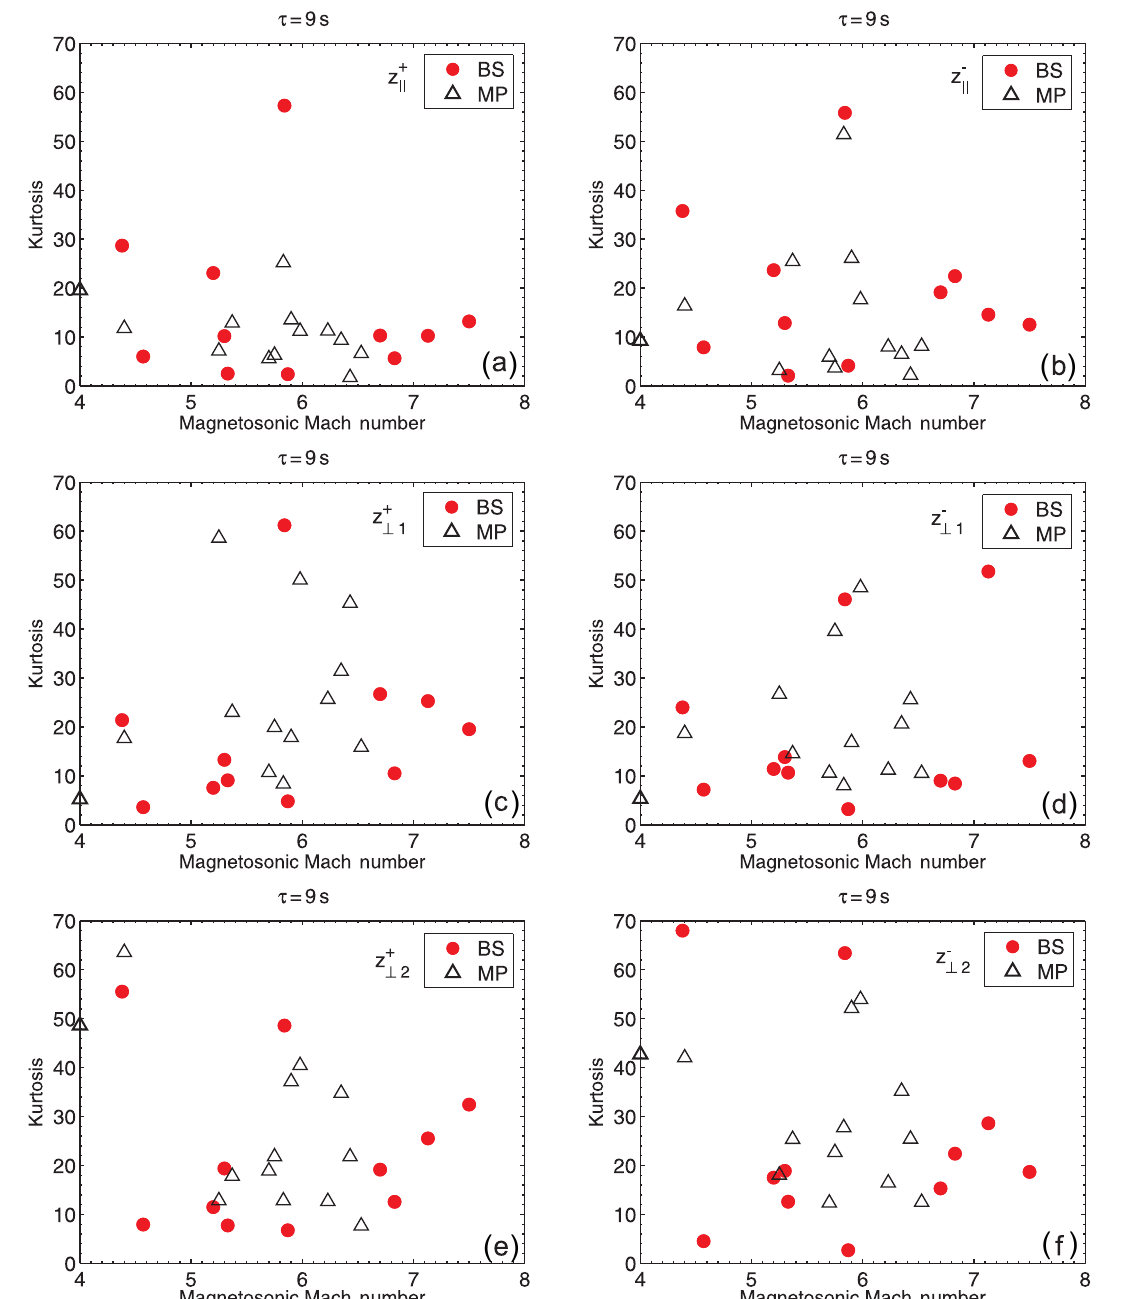
Figure 11. Kurtosis of the increments of the Elsässer vectors, δ z ± , in the magnetosheath vs. the magnetosonic Mach number for the com- ponents δz ± (cid:107) (parallel to the mean field vector B o , panels a and b ) and two components perpendicular to the field: (1) δz ± ⊥ containing B o and X axis in the GSE system, panels c and d ), and (2) δz ± ⊥ (BS, red circles) and magnetopause (MP, white triangles), as observed by THEMIS for cases listed in Table